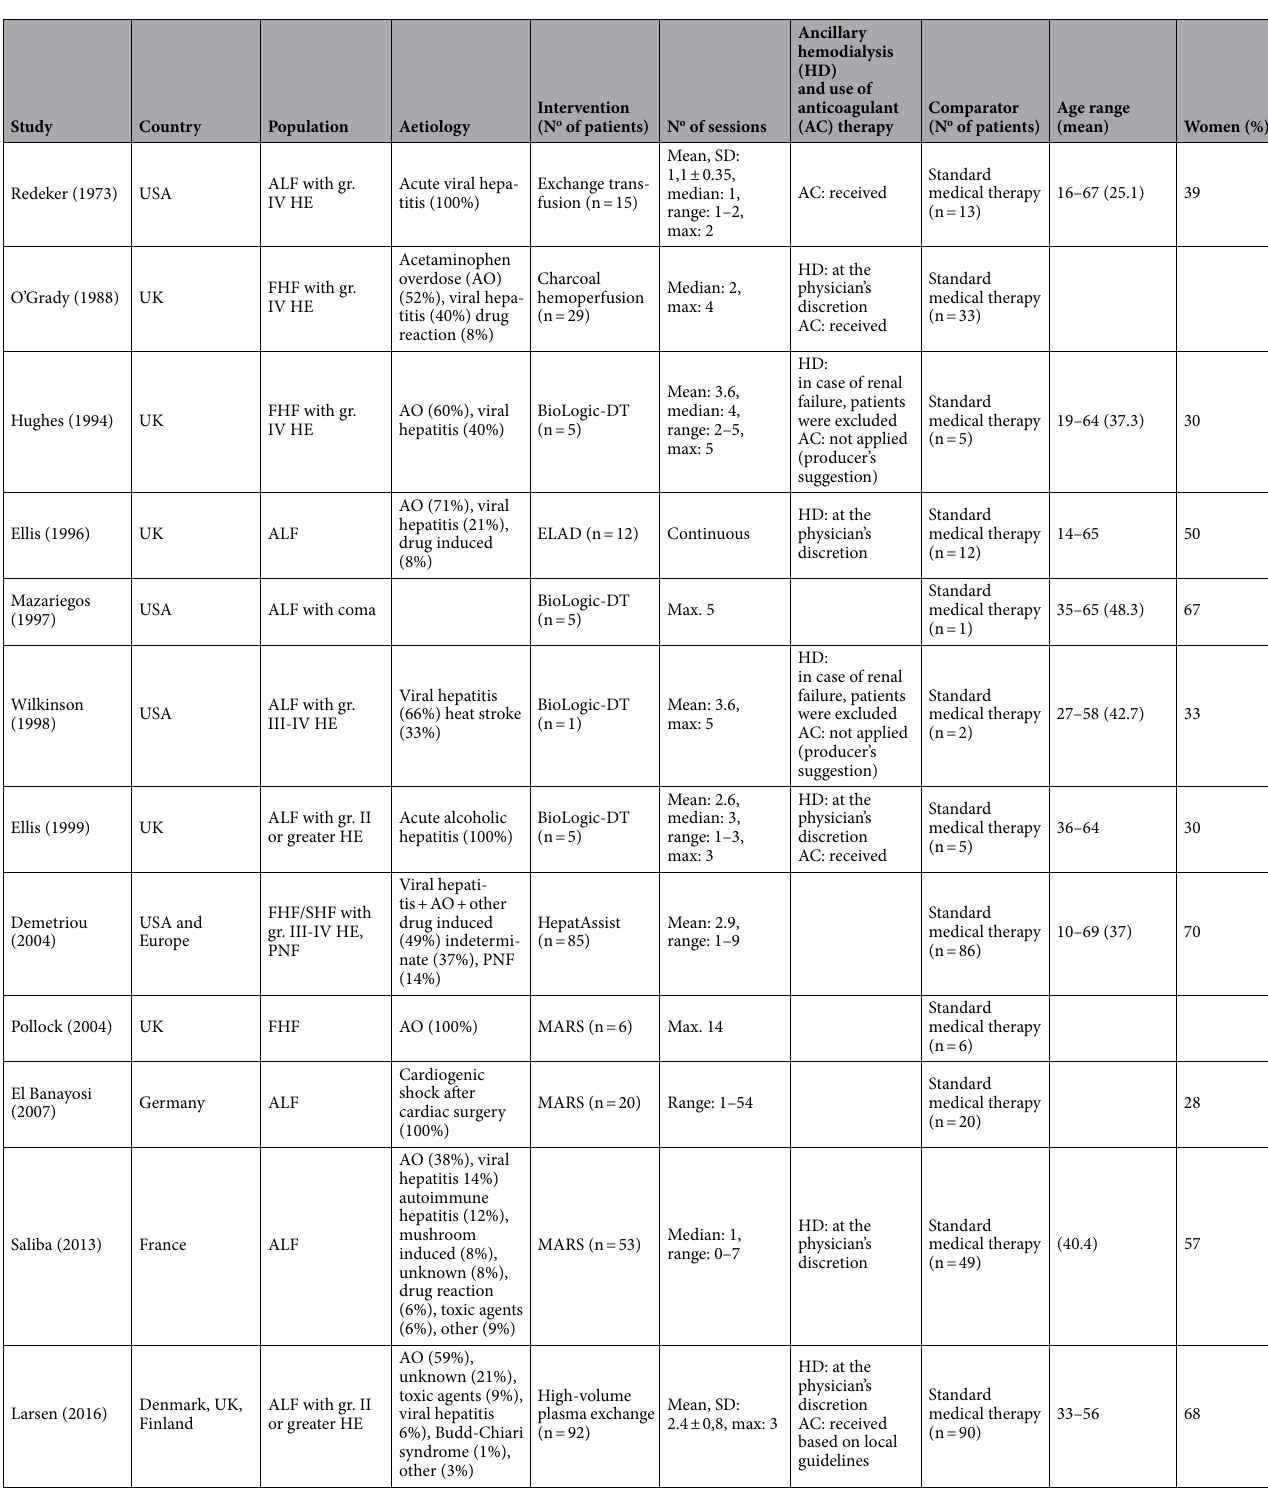
Table 1. Randomized controlled trials included in the systematic review and network metaanalysis. Table contains study characteristics of the included trials. Blank cells indicate that the data were not reported in the article. Abbreviations: ALF: acute liver failure, HE: hepatic encephalopathy, HD: hemodialysis, AC: anticoagulant, SD: standard deviation, max: maximum, USA: United States of America, FHF: